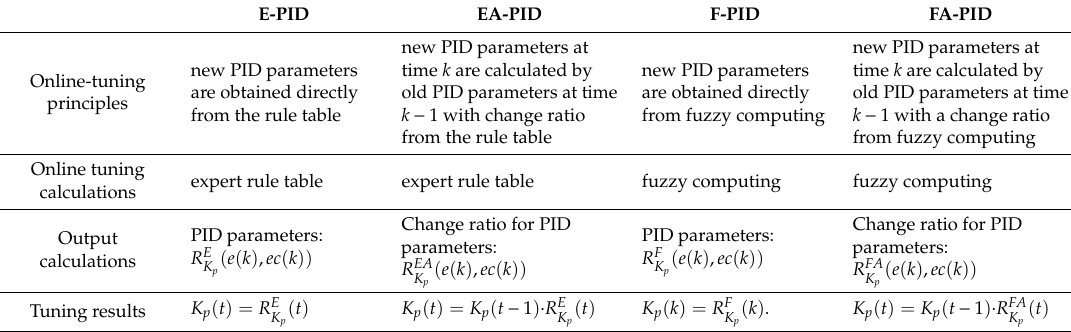
Table 5. Comparison between F-PID, E-PID, FA-PID, and EA-PID methods.